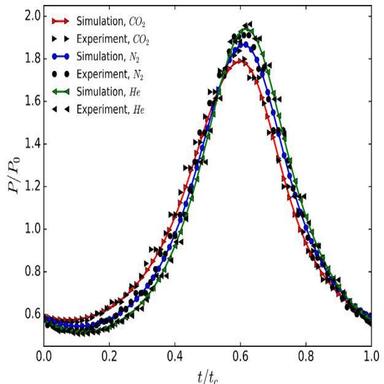
Comparison of the pressure profiles for runs in the packed bed with different gases. Conditions: T0 = 30 C; u ¼ 0:5p; Stroke1 = Stroke2 = 0–100 mm; tc = 4 s.